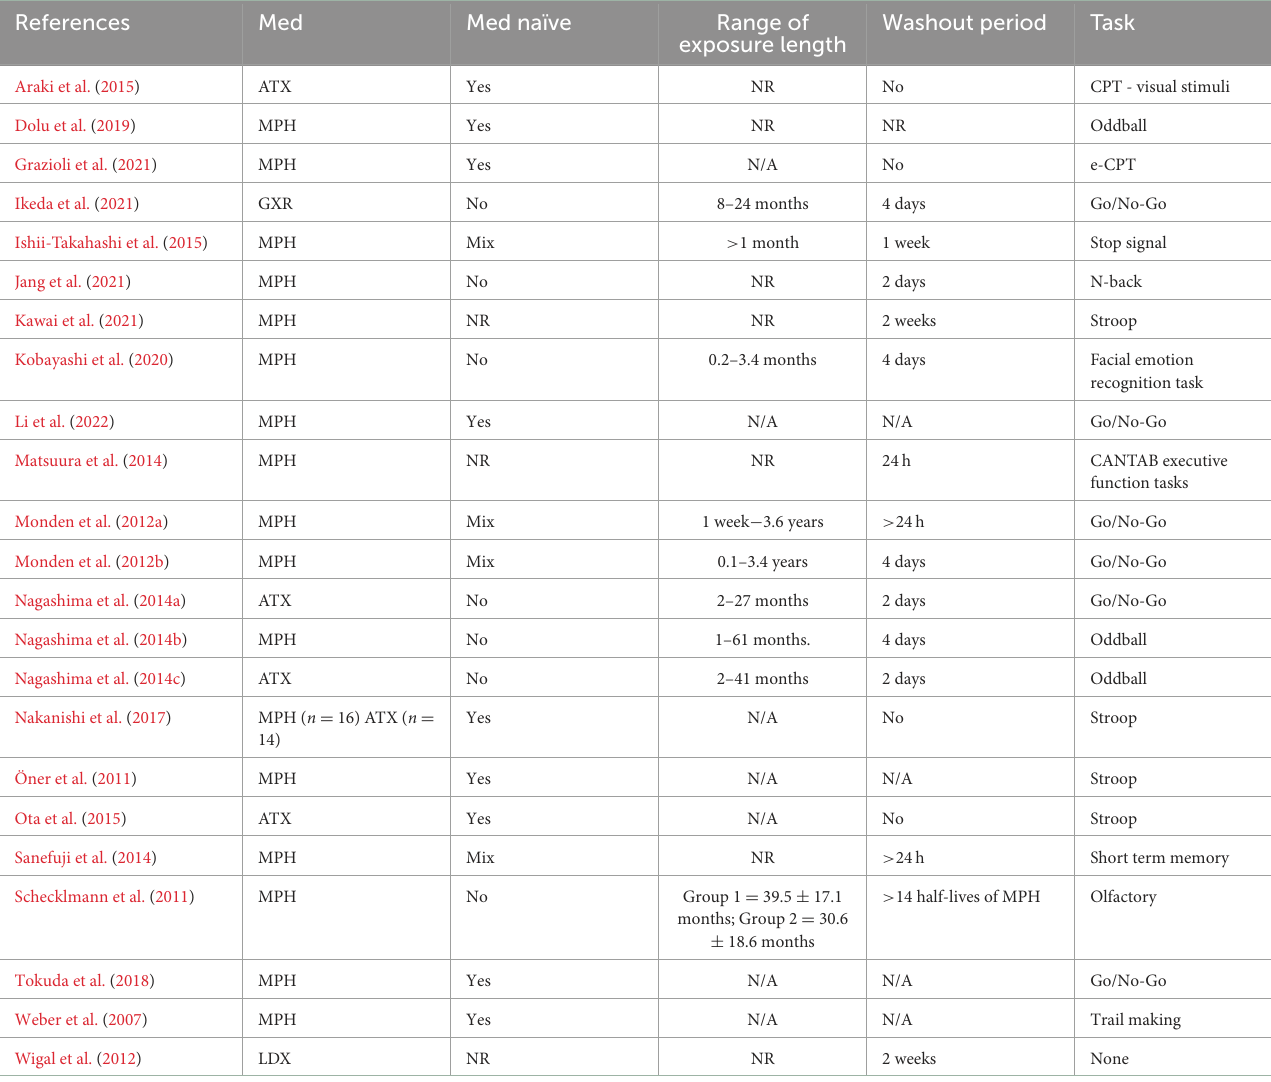
TABLE 2 Procedural variables from retrieved